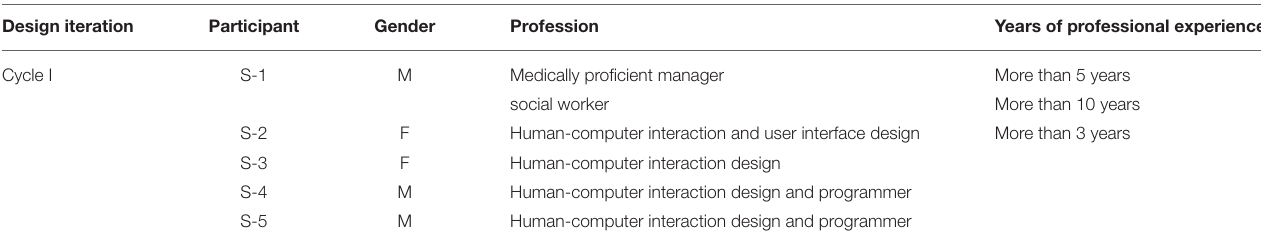
TABLE 2 | Demographics of